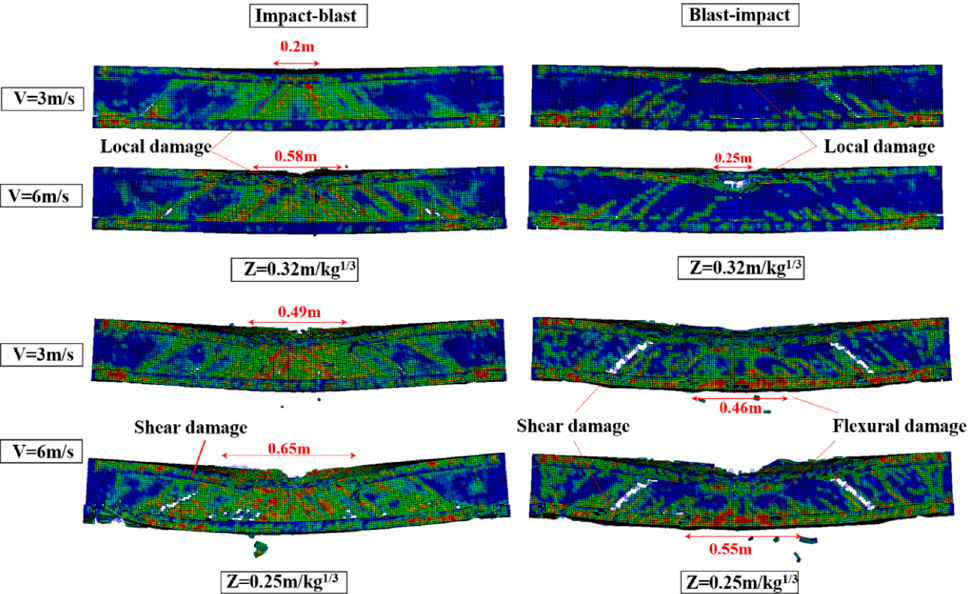
Figure 6. Numerical analysis results of damage behavior of I-shaped RC beams under different im- pact rates and proportional distances.